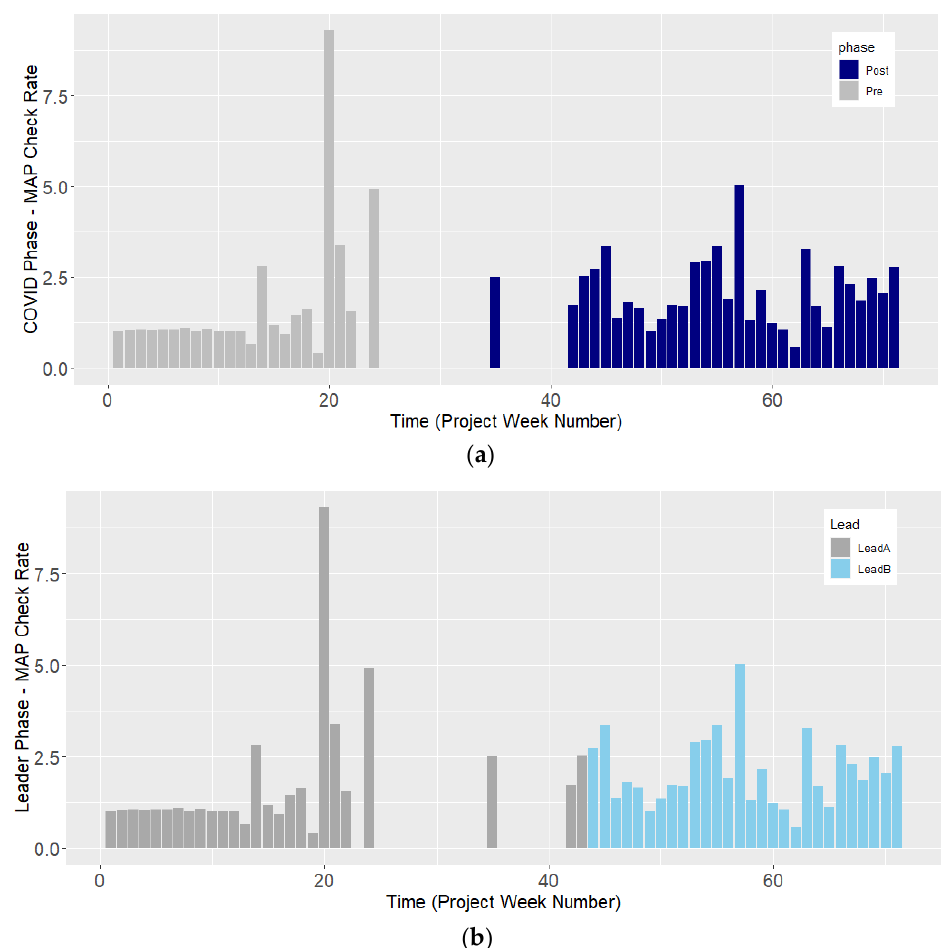
Figure 10. ( a ) Supervisor observation & intervention rate by COVID Phase, ( b ) Supervisor observa- tion & intervention rate under different Project Leaders.